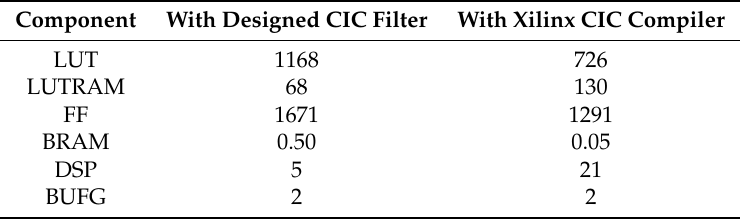
Table 6. Resource-utilization comparison of a full one channel. Designed CIC filter vs. IP